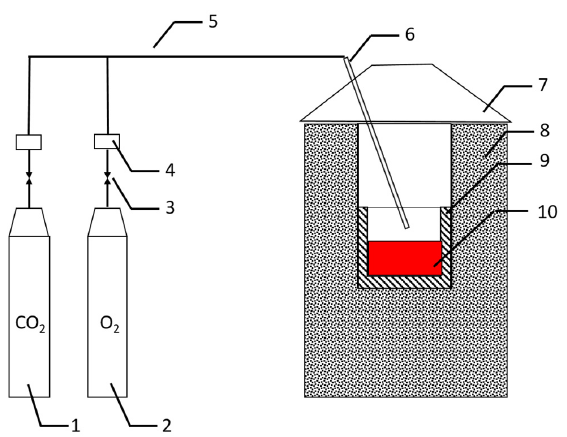
Figure 1. Schematic diagram of the experimental apparatus (1. CO 2 gas bottle; 2. O 2 gas bottle; 3. pressure reducing valve; 4. flowmeter; 5. gas tube; 6. top lance; 7. dust hood; 8. induction furnace; 9. MgO crucible; 10. HCFeMn melt).